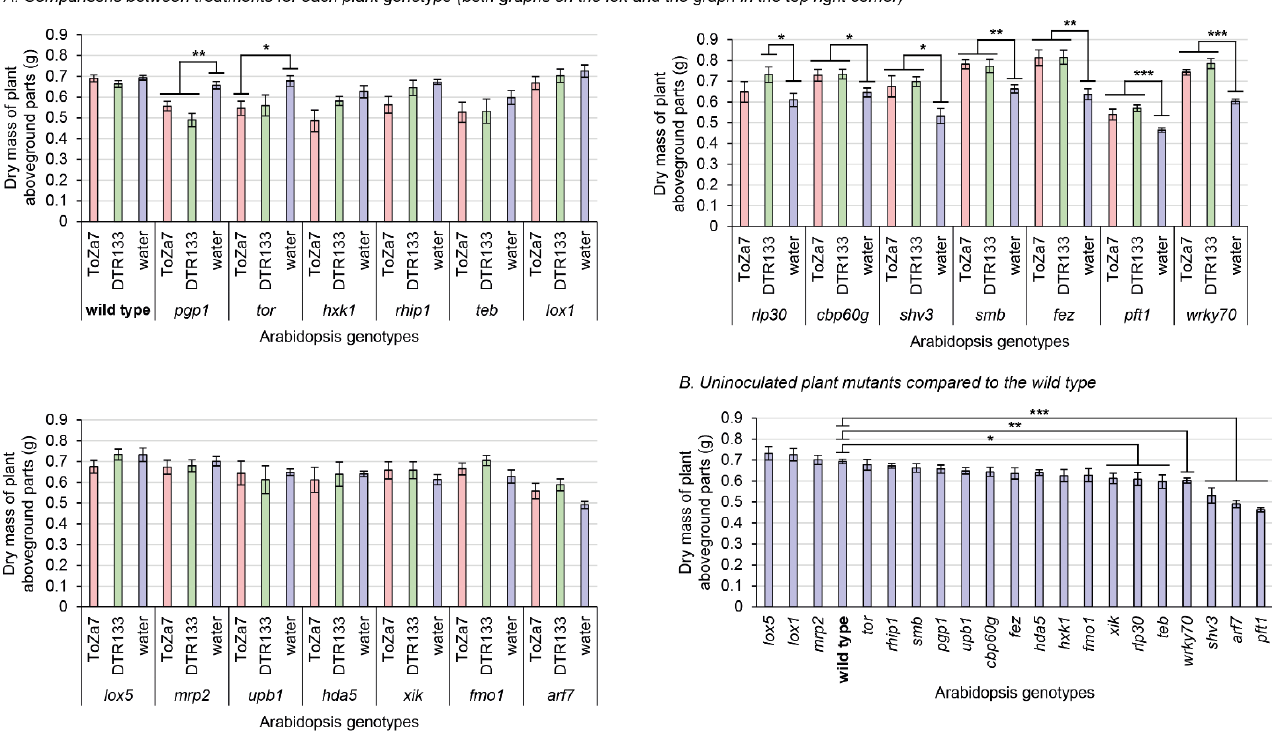
Figure 2. Dry mass of plant aboveground parts three weeks following inoculation with P . chlororaphis subsp. piscium strains ToZa7 and DTR133 for 21 A . thaliana genotypes. Asterisks refer to significant differences between groups defined by Fisher’s least significant difference test. * p -value < 0.05; ** p -value < 0.01; *** p -value < 0.001. Bars indicate standard errors ( n = 10). ( A ) Comparisons between treatments for each plant genotype (graphs have been divided for easy layout). ( B ) Uninoculated plant mutants compared to the wild type.